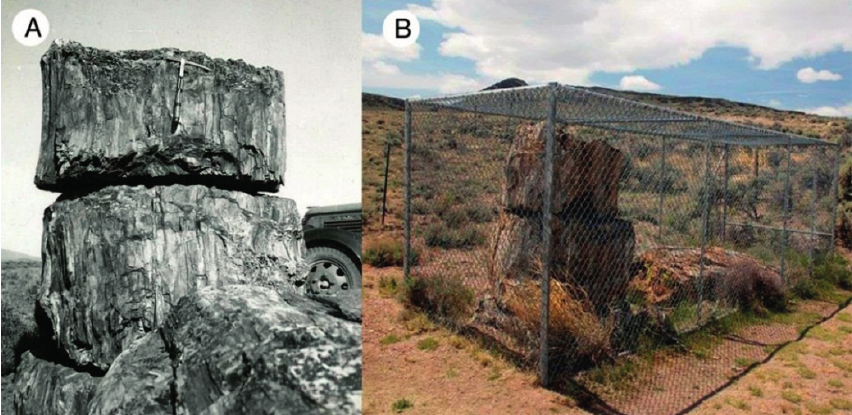
Figure 1. Lund Petrified Forest, in Washoe County, Nevada, contains remains of more than 200 stumps and logs. ( A ) A 1946 photo of the most prominent stump (photo courtesy of University of Nevada Reno Library Special Collections Department); ( B ) The same site in 2014 showing a protective fence installed by the Bureau of Land Management.